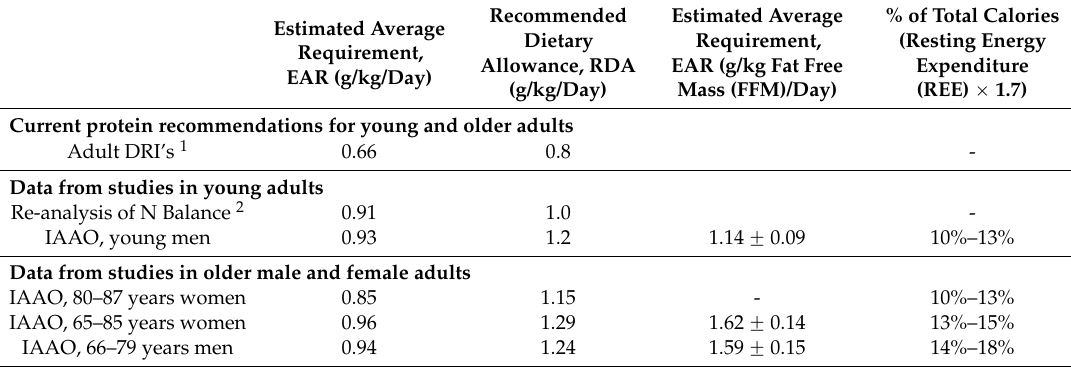
Table 1. Protein requirements in